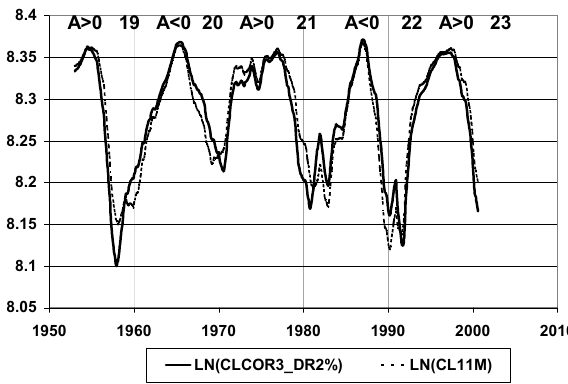
Fig. 5. Climax NM data: comparison of observed LN(CL11M) with expected from convection-diffusion modulation, with cor- rected drift effects, according to the third approach with A dr =2% (at W =75). Fig. 6. Comparison of predicted convection-diffusion modu- lation (PR CD) and predicted, taking into account drift effects (PR CD+DR) with observation by Climax NM for the period be-